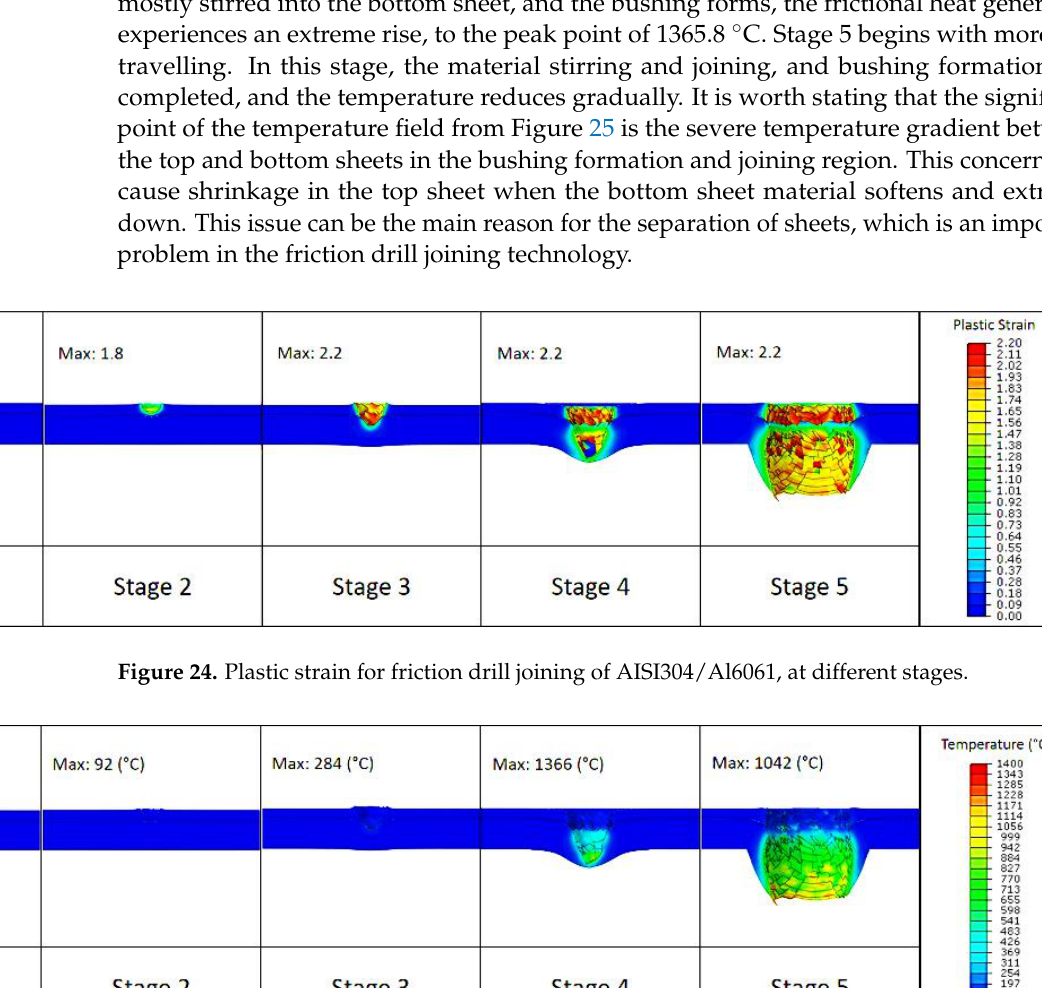
Figure 24. Plastic strain for friction drill joining of AISI304/Al6061, at different stages.